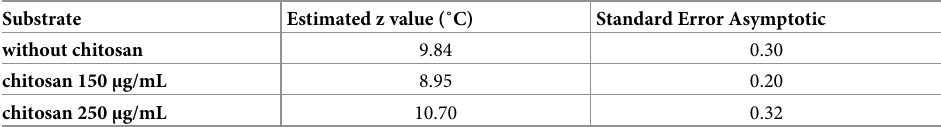
Table 2. Estimated z values (˚C) in different